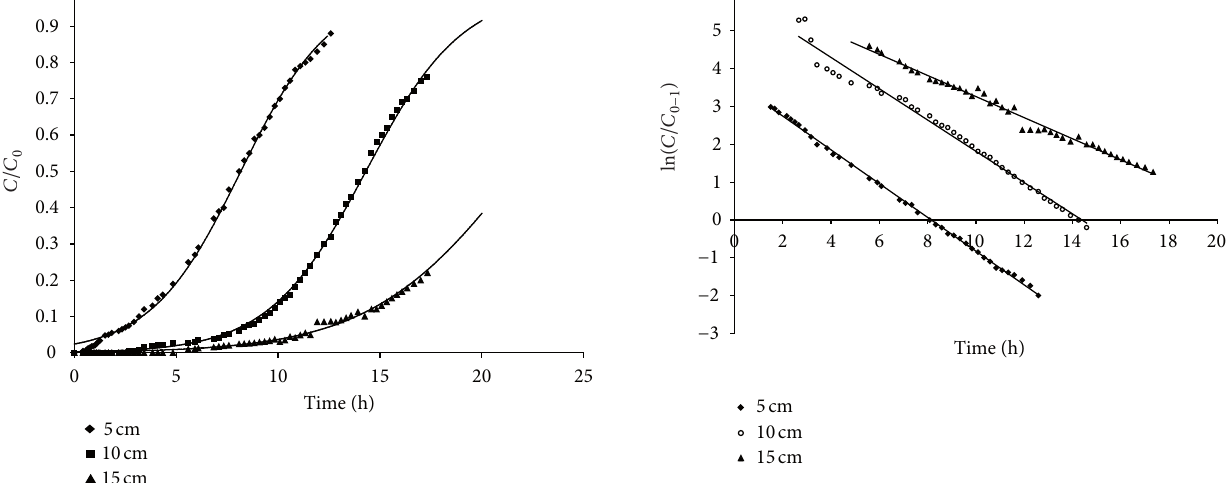
F 3: Break-through curves for MB adsorption onto GNSP at different bed heights. Flow rate = 1l/h, initial dye concentration = , pH = 7. 0.2kg/m 3